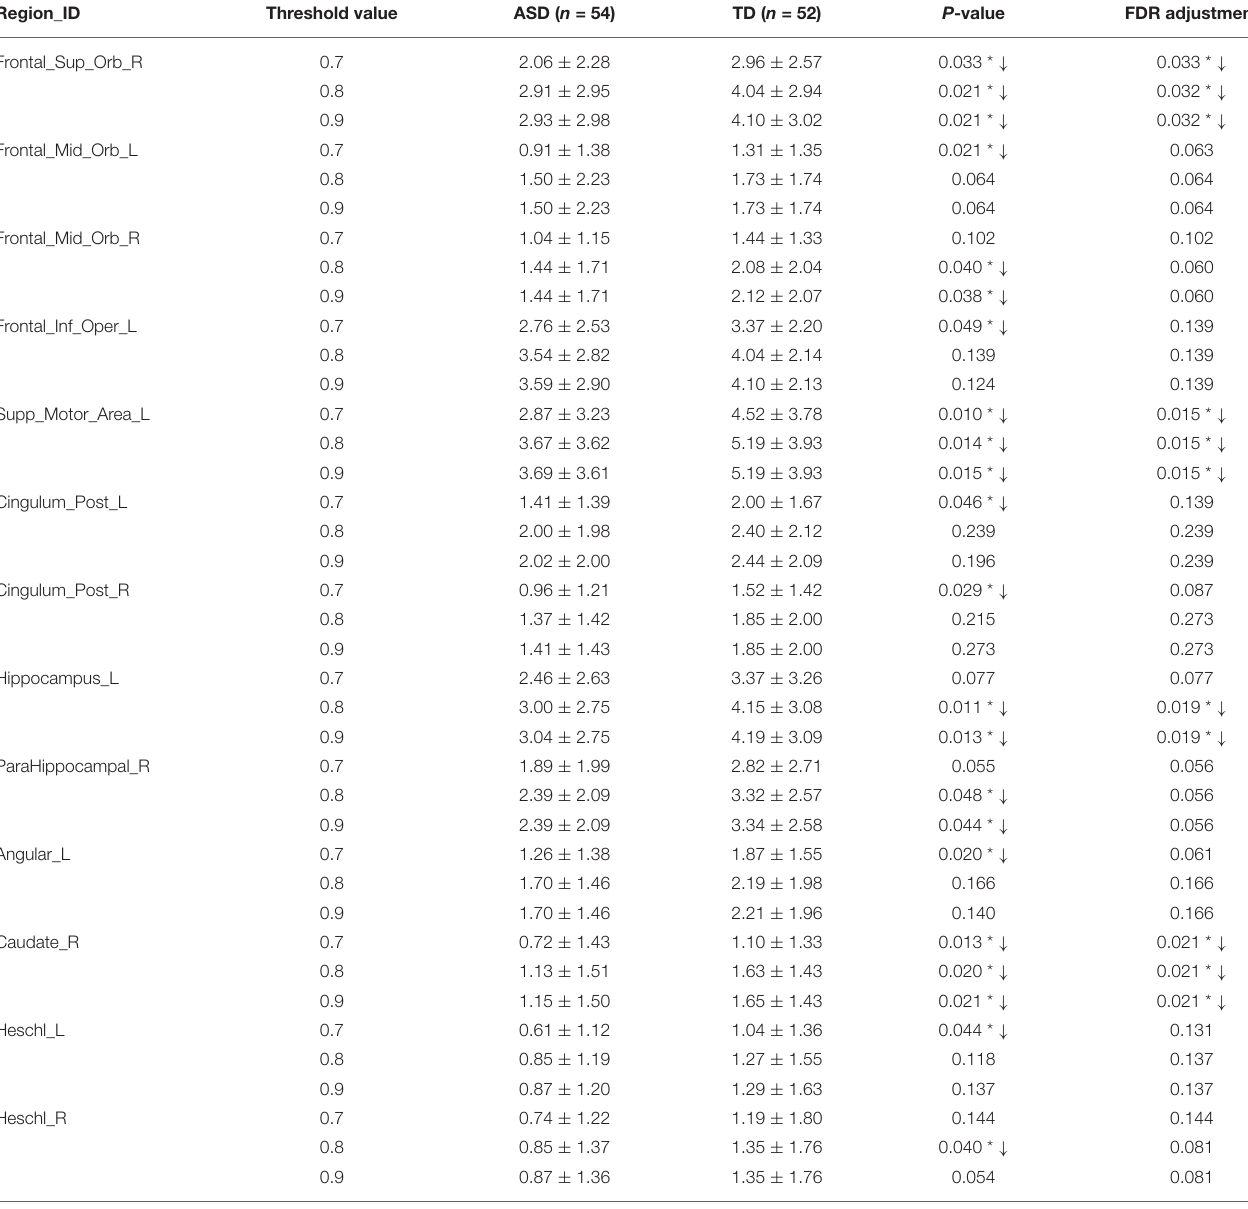
TABLE 2 | Statistically significant differences in the numbers of FC neural circuits in the involved brain regions of the two groups. Region_ID Threshold